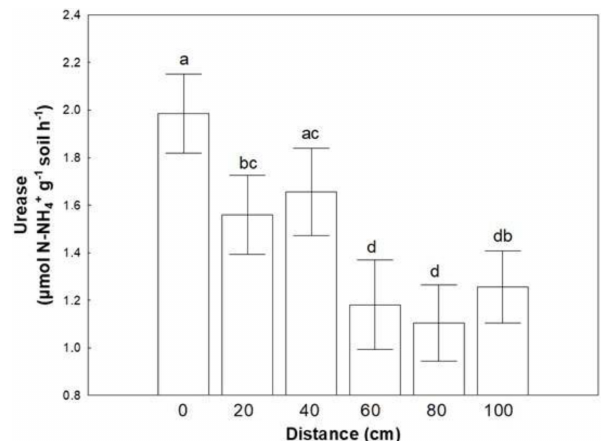
Figure 2. Mean values ( ± SE) of urease activity at 0, 20, 40, 60, 80 and 100cm distance, respectively, from the trunk of Erica spp. The letters a, b, c and d indicate the significant differences between distances revealed by an LSD